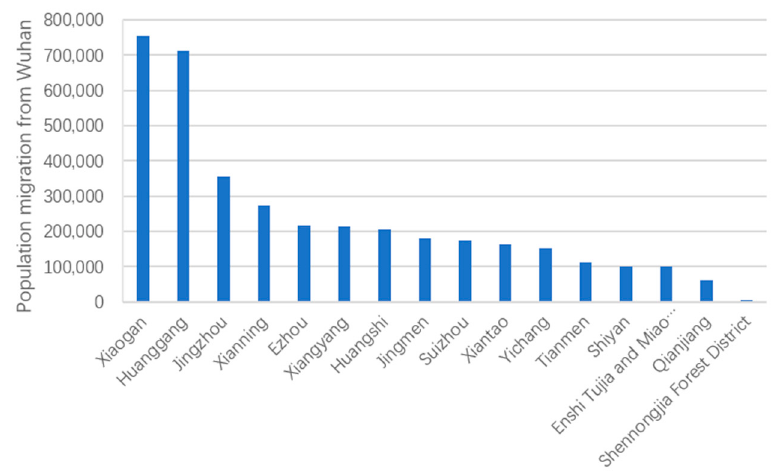
Figure 4. Population migration from Wuhan to cities in Hubei Province.